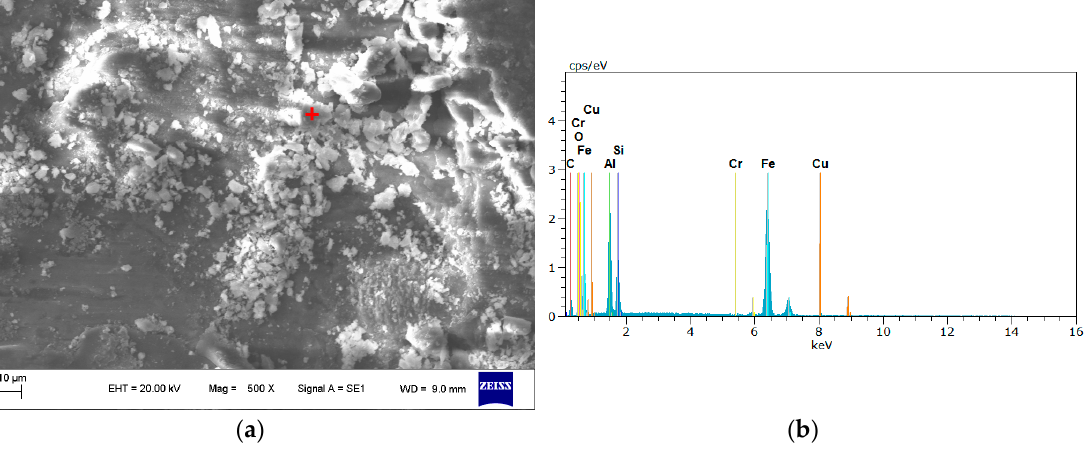
Figure 9. An example of EDX analysis of fretting debris. ( a ) SEM image indicating the area of analysis; ( b ) spectrum of the fretting debris.